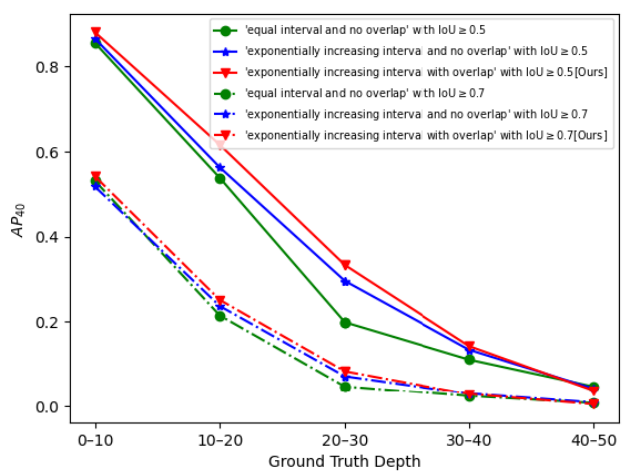
Figure 14. The AP 40 using different depth stratification models on the Bird’s Eye View object detection task in different depth